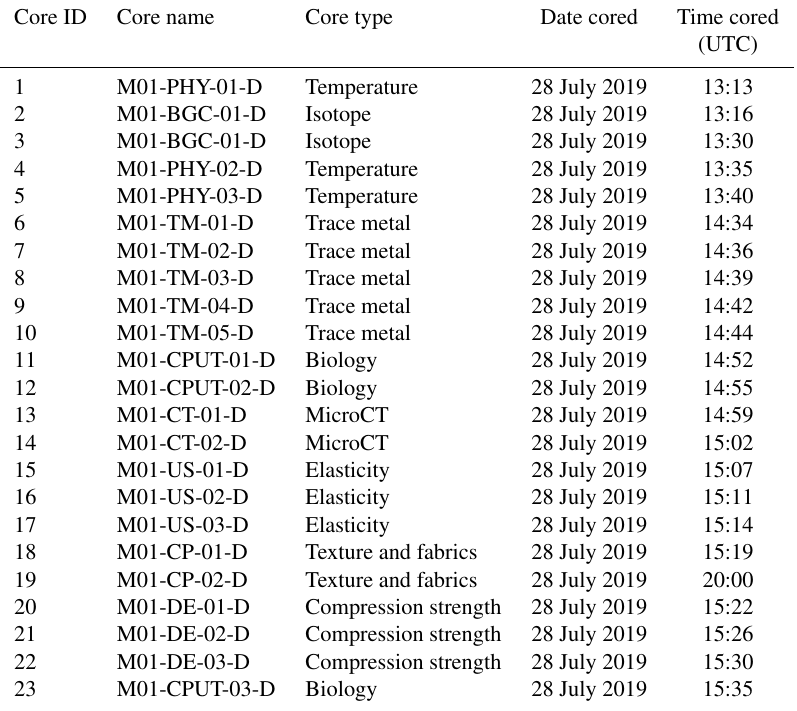
Table A5. Overview of core IDs of Pancake D, corresponding core names, testing designation, and date and time when cored. Core